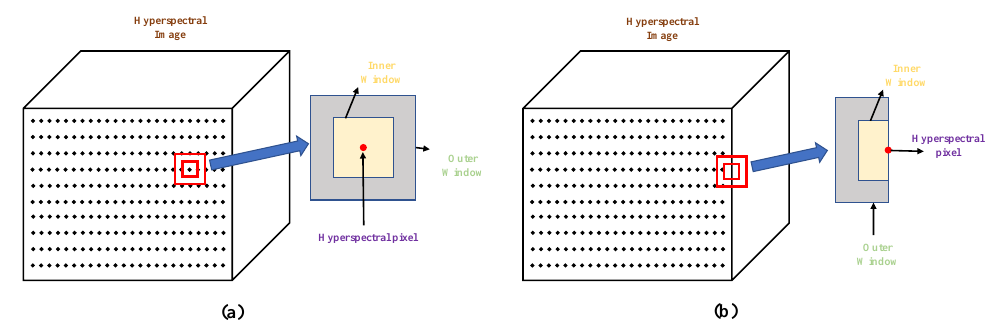
Figure 7. The illustration of the dual-window based local average strategy for ( a ) inner pixels and ( b ) boundary pixels.